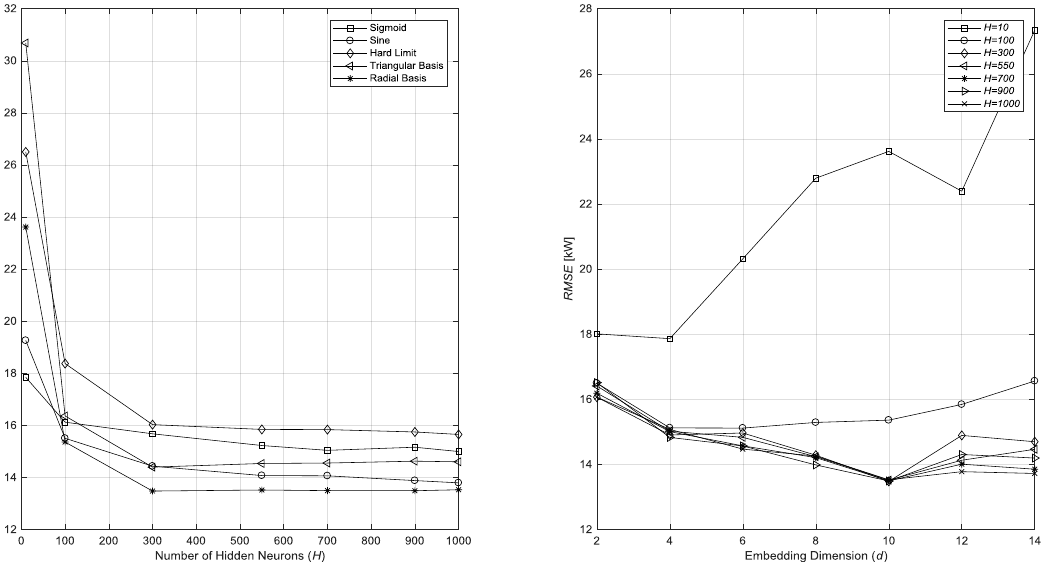
Figure 7. Influence of the activation function vs. different numbers of hidden neurons ( left ) and influence of the numbers of hidden neurons considering different embedding dimensions ( right ) on the RMSE in ELM model.